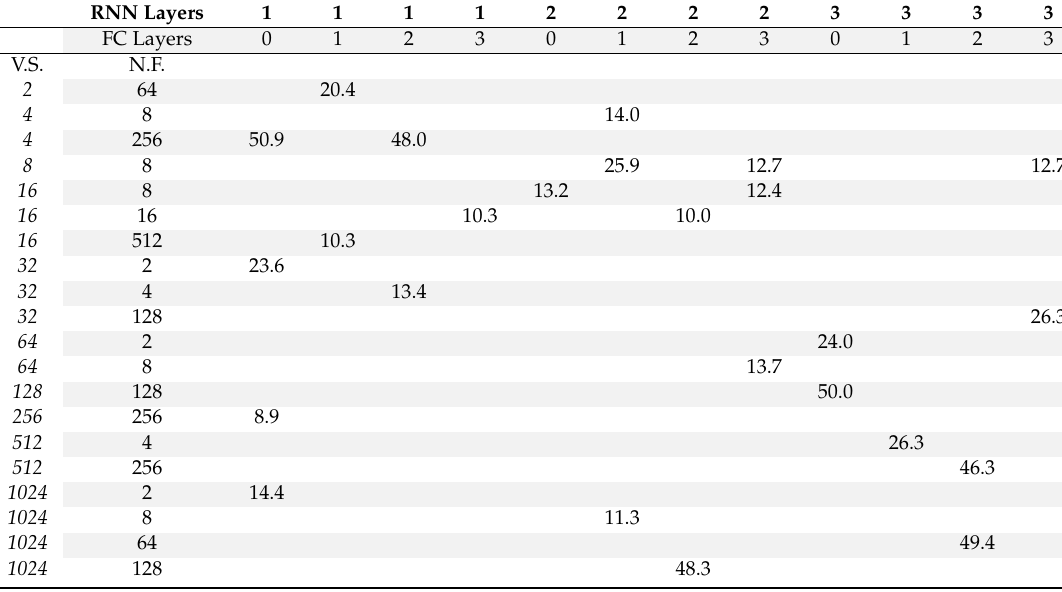
Table 3. Equal error rate (EER) results from the random grid approach (%). V.S. = vector size, N.F. = number of filters, FC = fully